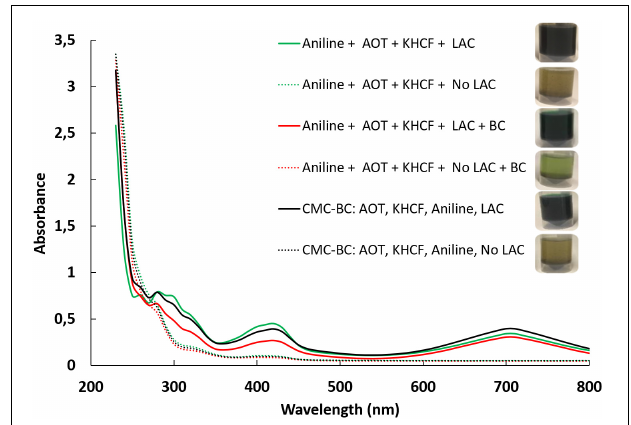
FIGURE 2 | UV–Visible spectra of polyaniline solutions in the presence of template (CMC).